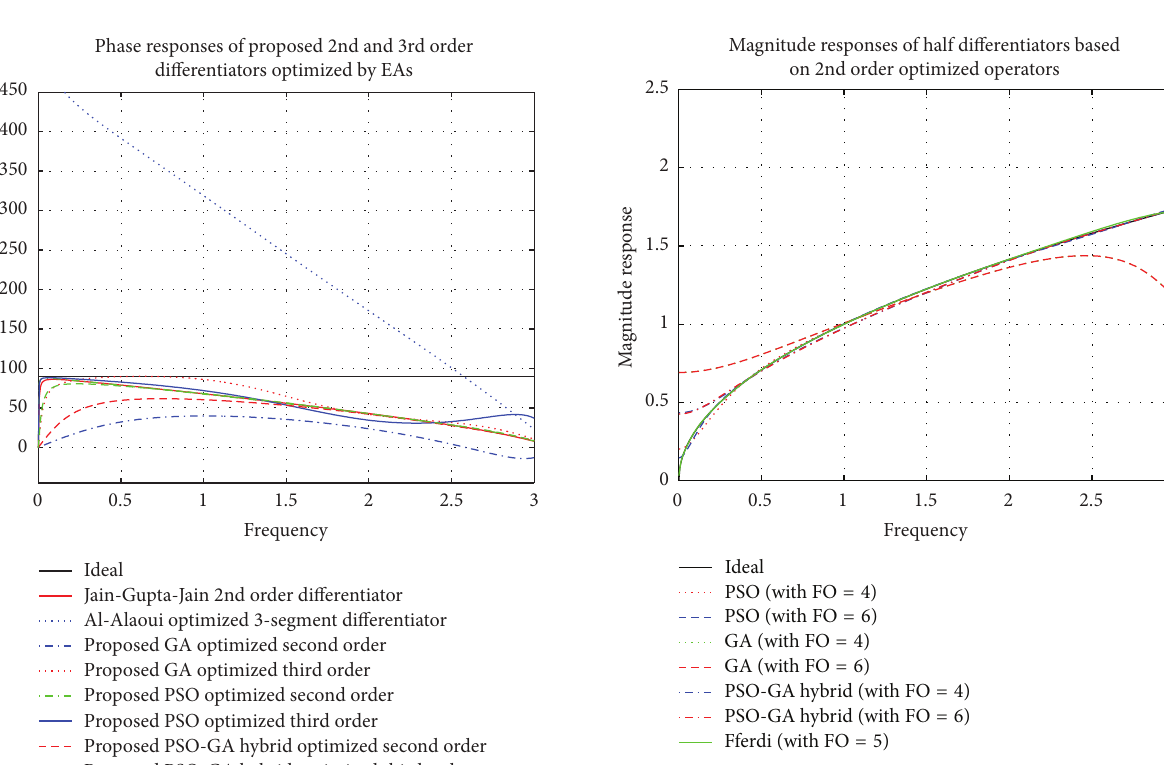
Figure 6: Comparison of magnitude responses of proposed half differentiators based on 2nd order optimized differential operators.